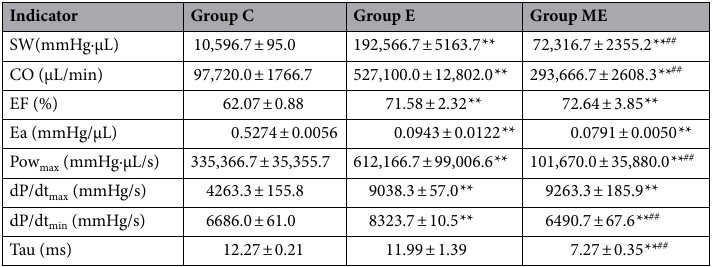
Table 2. Changes in cardiac baseline hemodynamics after MOTS-c treatment during exercise training. * p < 0.05, ** p < 0.01, compared to group C. # p < 0.05, ## p < 0.01, compared to group E. (C = Control, E = Exercise training, ME = Exercise training combined with MOTS-c treatment. SW = stroke work, CO = cardiac output, SV = stroke volume, EF = ejection fraction, Ea = arterial elasticity, Pow max = maximum work, dP/dt max = the maximum rate of increase in left ventricular pressure, dP/dt min = the maximum rate of decrease in left ventricular pressure, Tau = time constant of isovolumic